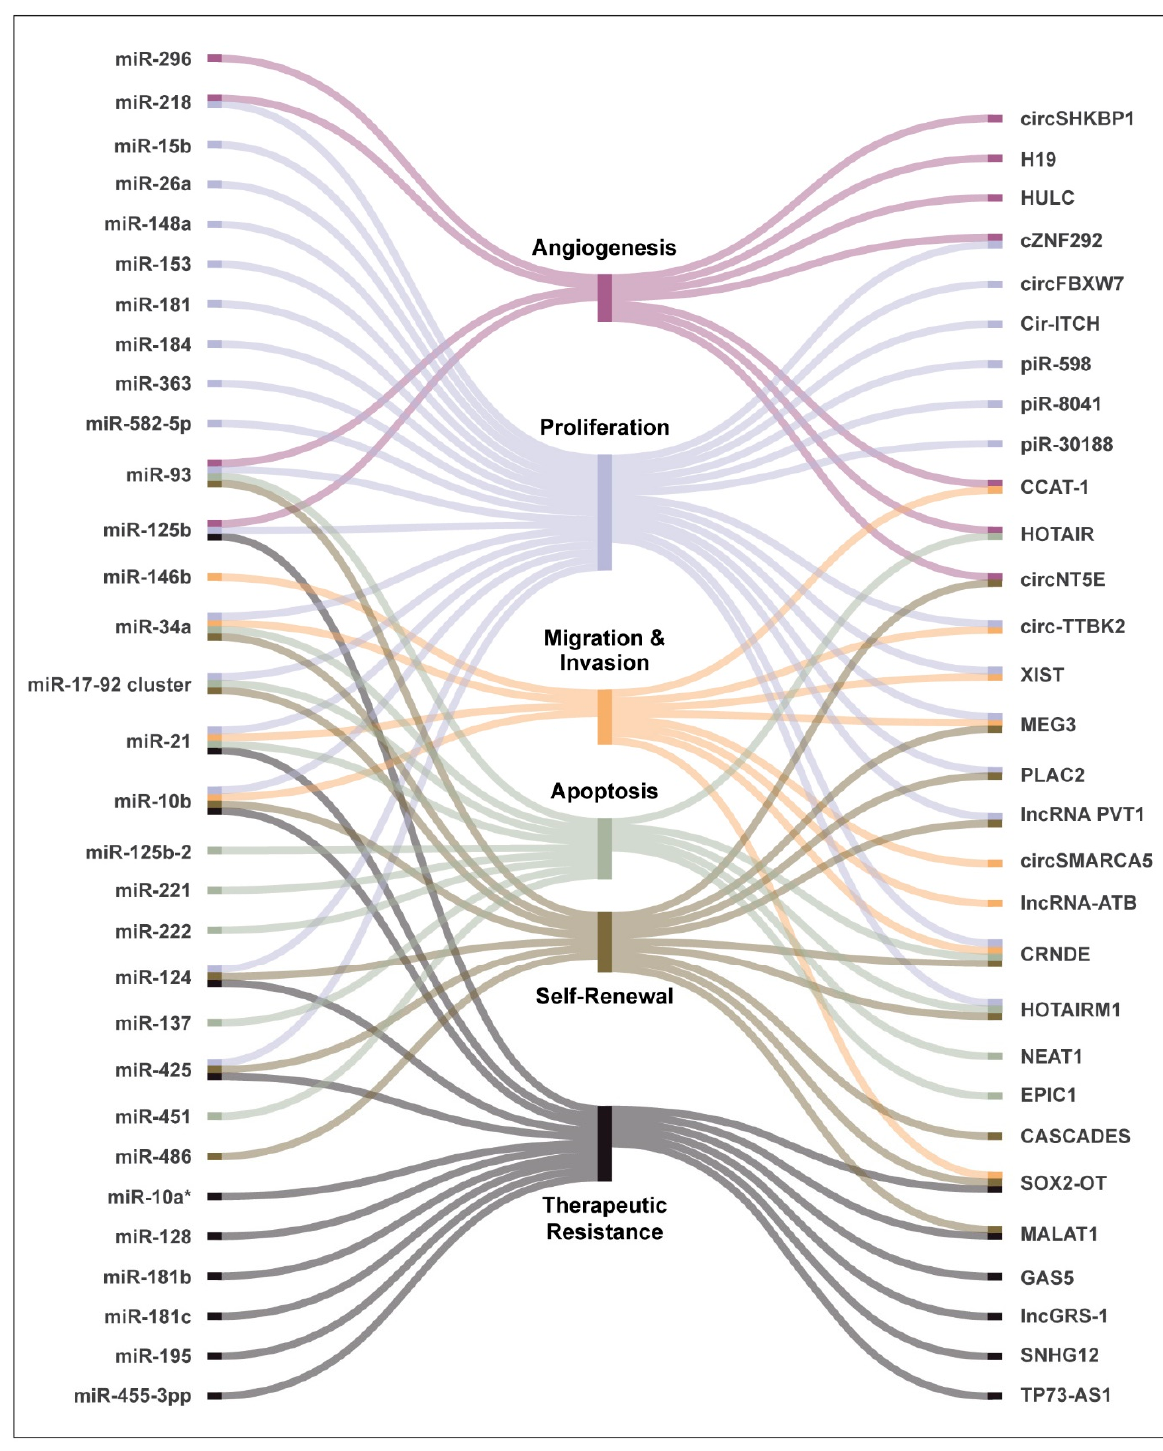
Figure 2. NcRNAs and regulation of hallmarks of GBM . Noncoding RNAs can regulate several hallmark processes associated with gliomas including controlling cellular proliferation and apoptosis, regulating migration and invasion potential of the tumor cells, modulating therapeutic response, self-renewal, and angiogenesis.